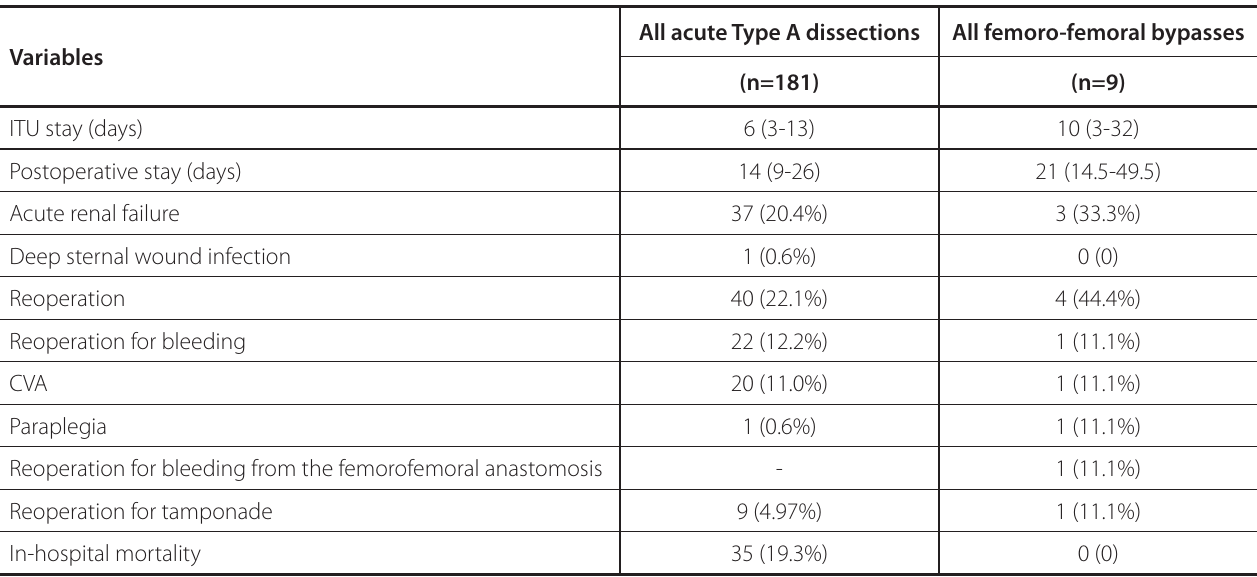
Table 3 . Patients’